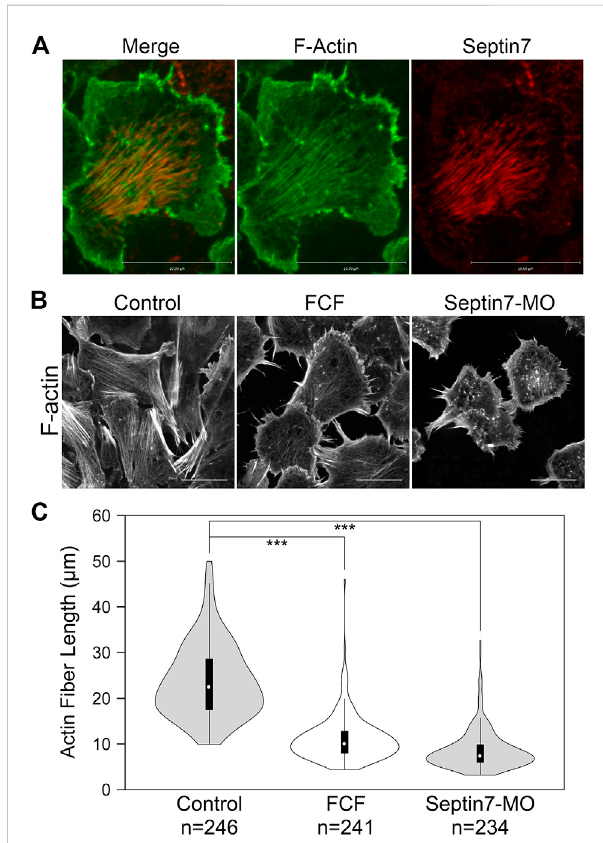
FIGURE 2 Septin fi laments co-align with ventral actin stress fi bers and is required for proper organization of actin stress fi bers. (A) Septin fi laments co-align with actin stress fi bers in neural crest cells. Septin7 antibody and phalloidin were used to visualize septin fi laments and actin fi laments, respectively. (B) Inhibition of septin fi laments by both Septin7-MO and FCF treatment leads to defects in actin stress fi ber formation comparing to controls (control-MO or ethanol-treated). Actin fi laments were visualized by live imaging againstGFP-Utrophin. (C) Thelengthofactin fi berswasmeasuredand plotted in violin plots. The black bars in the plot represent the middle 50% of values, and the central white dots indicate the median. Both FCFandSeptin-MOreducedthelengthofactin fi berssigni fi cantly.***, p < 0.001. Scale bar = 20